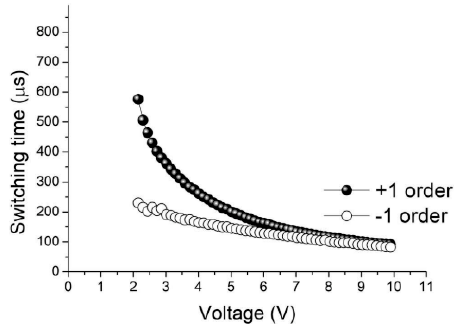
Figure 19. The dependence of switching time on applied electrical field [42].